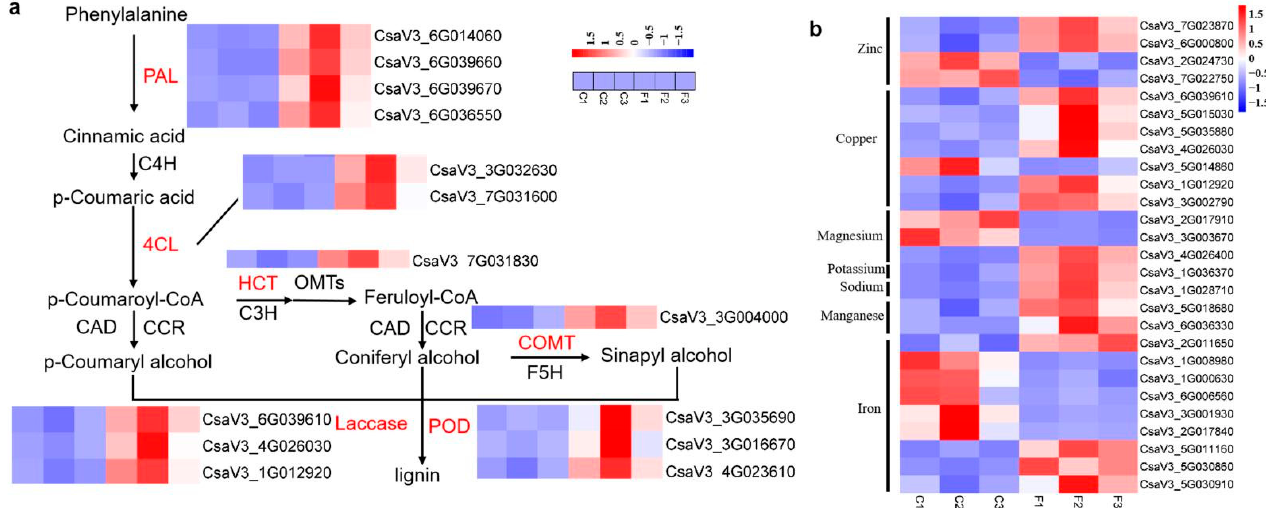
Figure 8. Heatmap of differentially expressed genes (DEGs) related to plant disease resistance in the stems of normal (C) and symptomatic (F) plants; 1, 2, and 3 represent the three repetitions. ( a ) DEGs involved in phenylalanine biosynthetic and lignin biosynthetic pathways. ( b ) DEGs related to mineral ions. A red rectangle indicates that the transcription level of the gene was upregulated, and a blue rectangle indicates that the transcription level of the gene was downregulated.